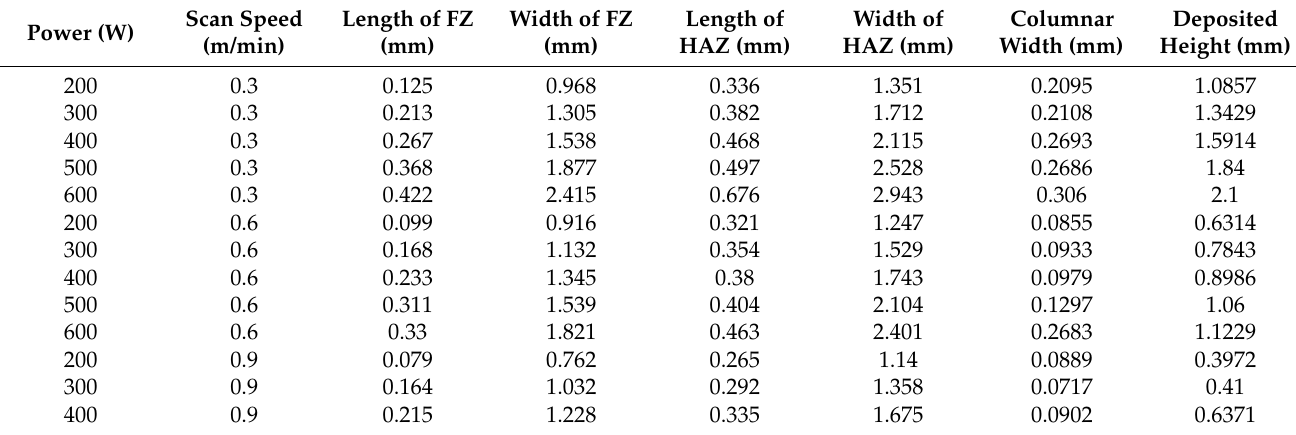
Figure 1. Macroscopic images of direct energy deposition-processed Ti–6Al–4V alloy samples fabricated at various powers and scan speeds. Table 1. Measured values of the melt pool and deposit geometries and average columnar grain size of DED-processed Ti–6Al–4V alloy samples under various process conditions.